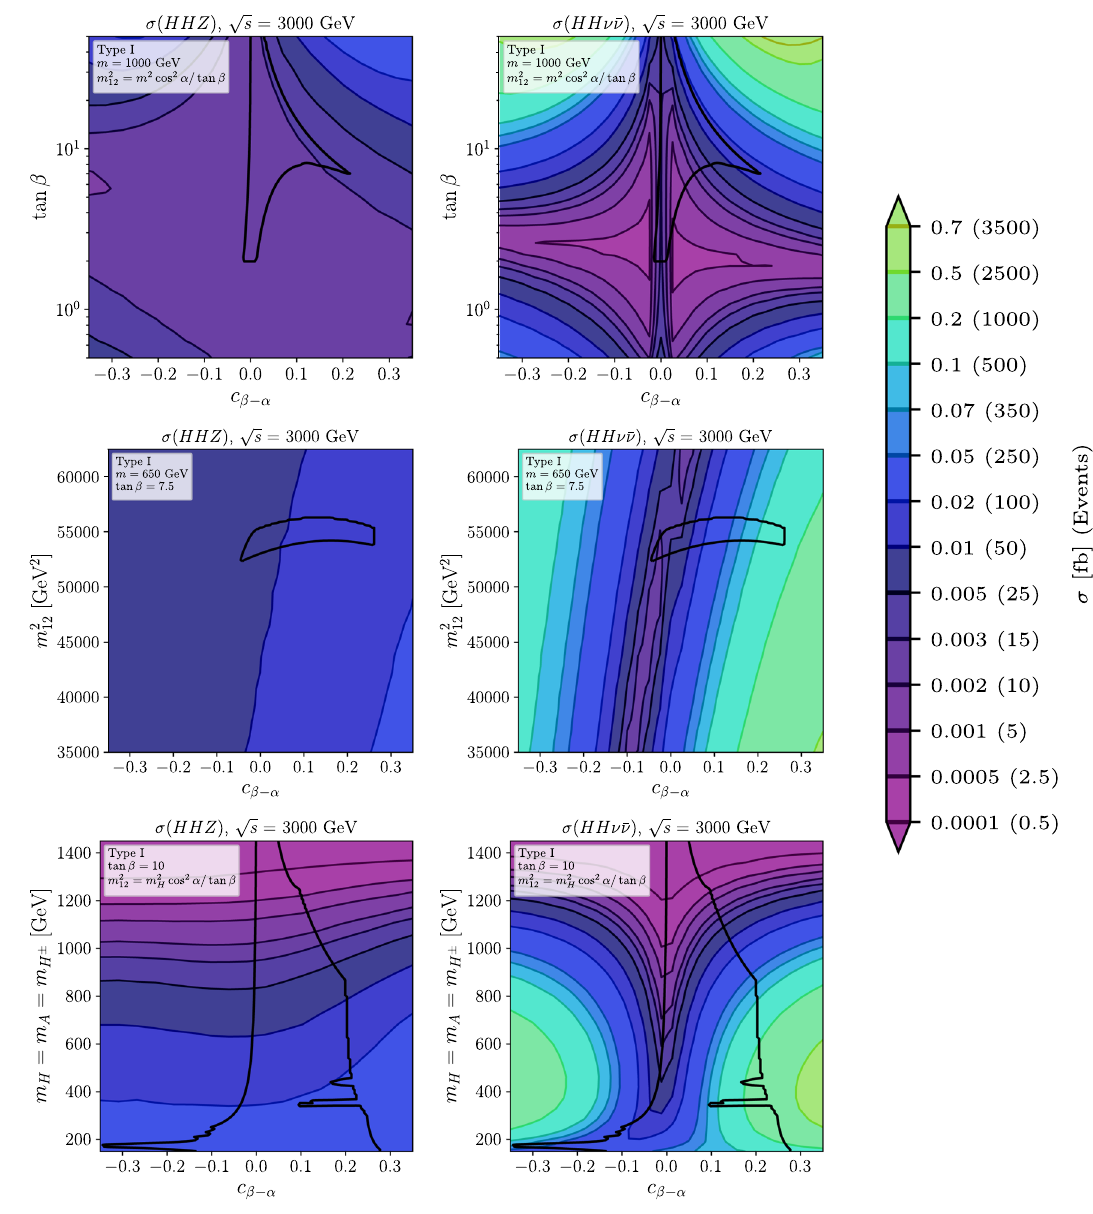
√ s = 3000 GeV for the benchmark planes 1-3 (top to bottom).